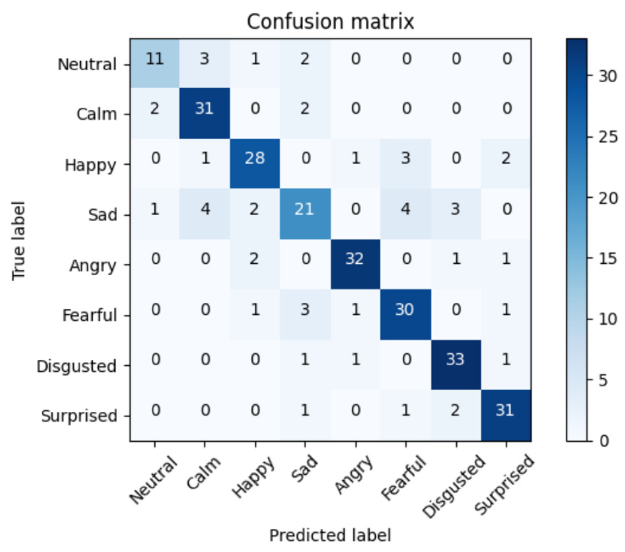
Figure 14. Average confusion matrix for the LSTM Algorithm. Accuracy = 82%.